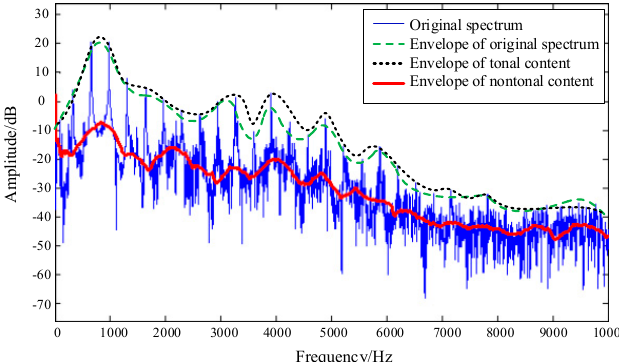
Figure 3. Spectrum and envelopes of the violin note E4.